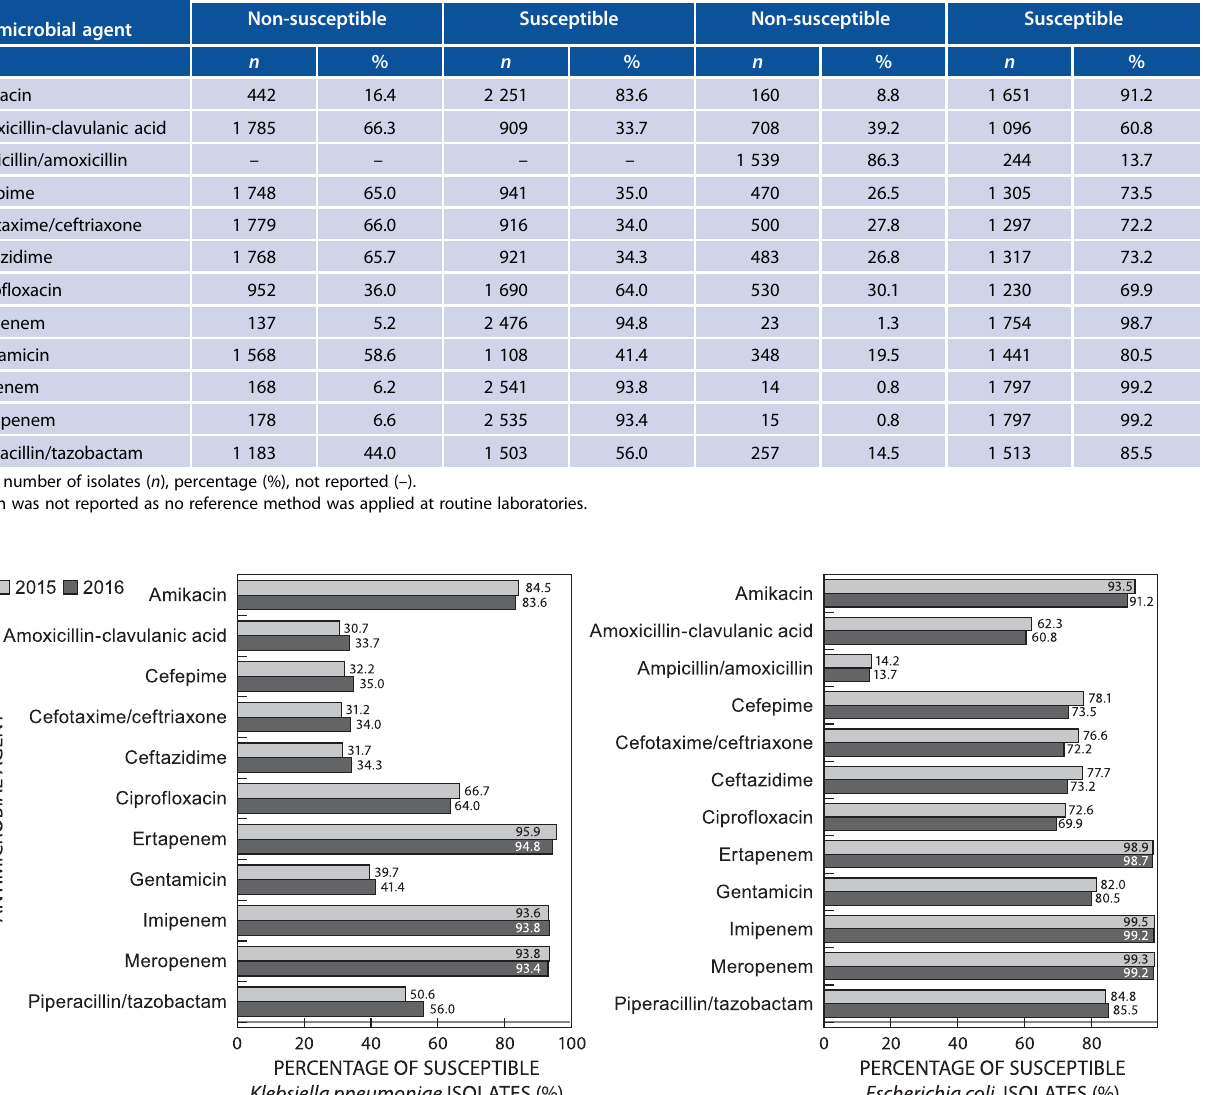
Antimicrobial agent